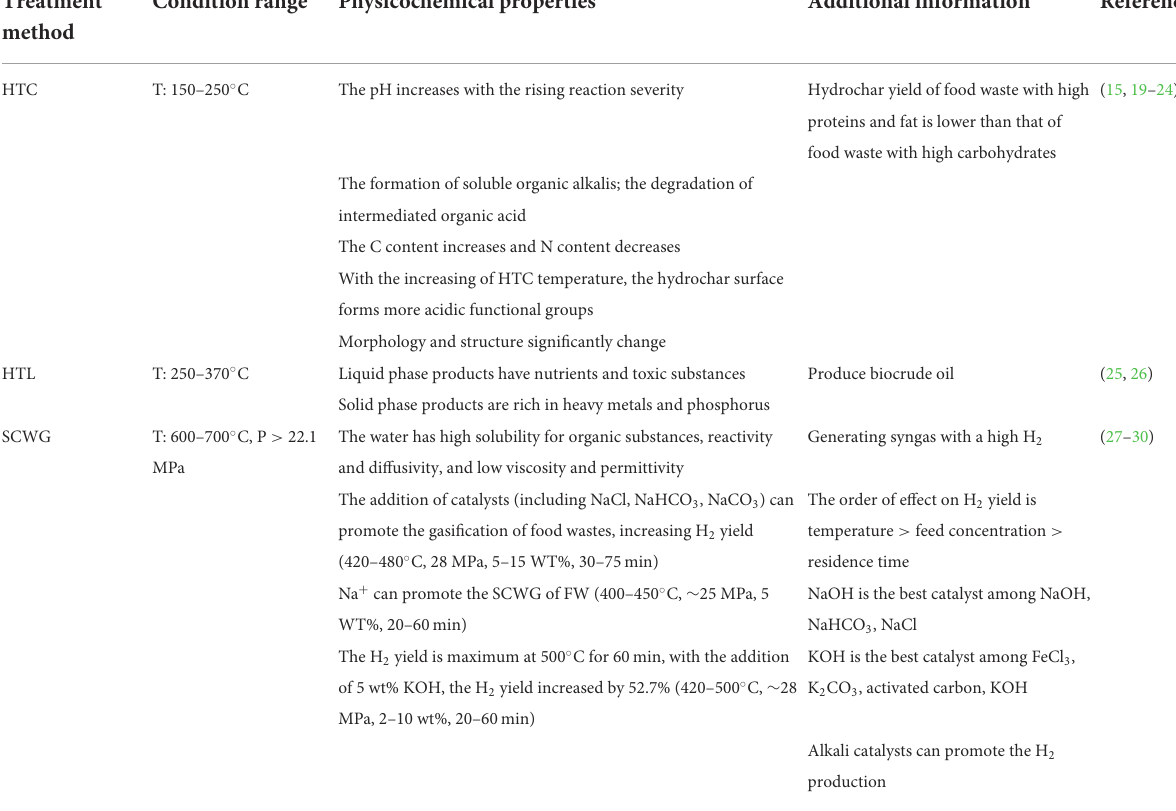
TABLE 1 Effects of hydrothermal treatment on food